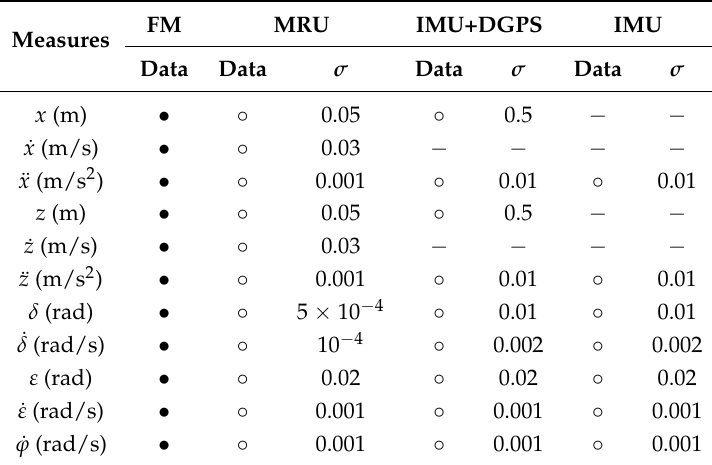
Table 2. Measurement frameworks available. Four cases are considered: Full Measurement (FM), Motion Reference Unit (MRU), Inertial Measurement Unit with Differencial GPS (IMU+DGPS) and Inertial Measurement Unit